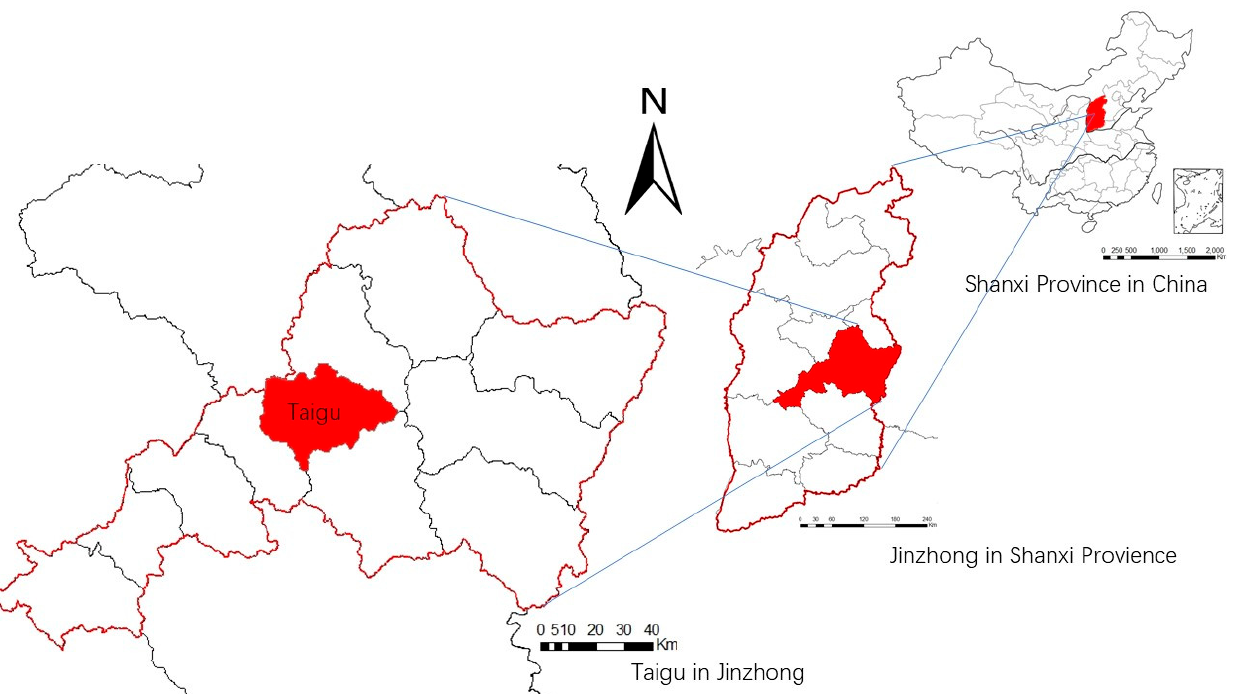
Figure 3. Maps showing the location of the Taigu district. Within the study area, ten gated communities were selected via stratified, purposive sampling. Considering the types of gated communities as a classification standard, the gated communities in Taigu were divided into two categories and five sub-categories, and using this as a foundation, the gated communities with a resident occupancy ratio less than 60% and an age of less than six years which have relatively new facilities and an associated community management system that may have not yet fully matured are excluded. Other aspects of gated communities were considered as well, such as location, management mode, size, etc. Building a foundation upon the above conditions through the stratified purposive sampling process, five “post workplace communities” and “new communities” were separately screened out by stratified purposive sampling. The stratified purposive sampling process is shown in Figure